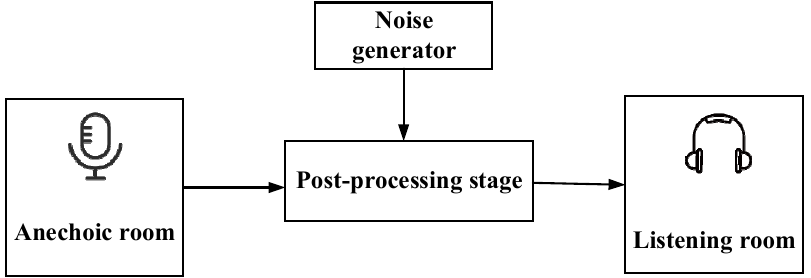
Figure 1. Experimental process of voice identity perception.